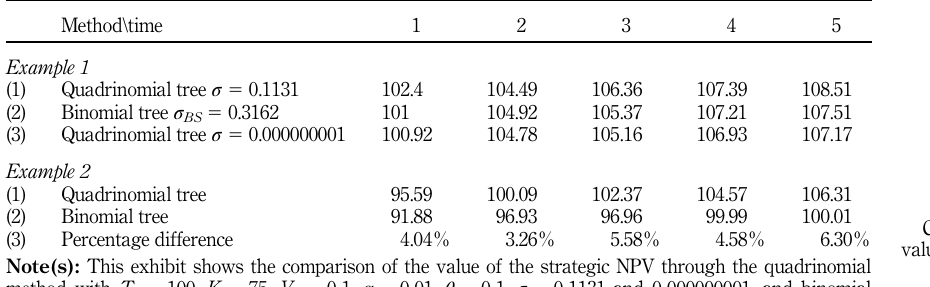
Table 3. Comparison of the value of the strategic NPV through